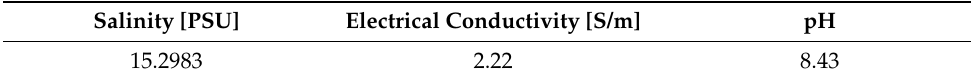
Table 5. Seawater